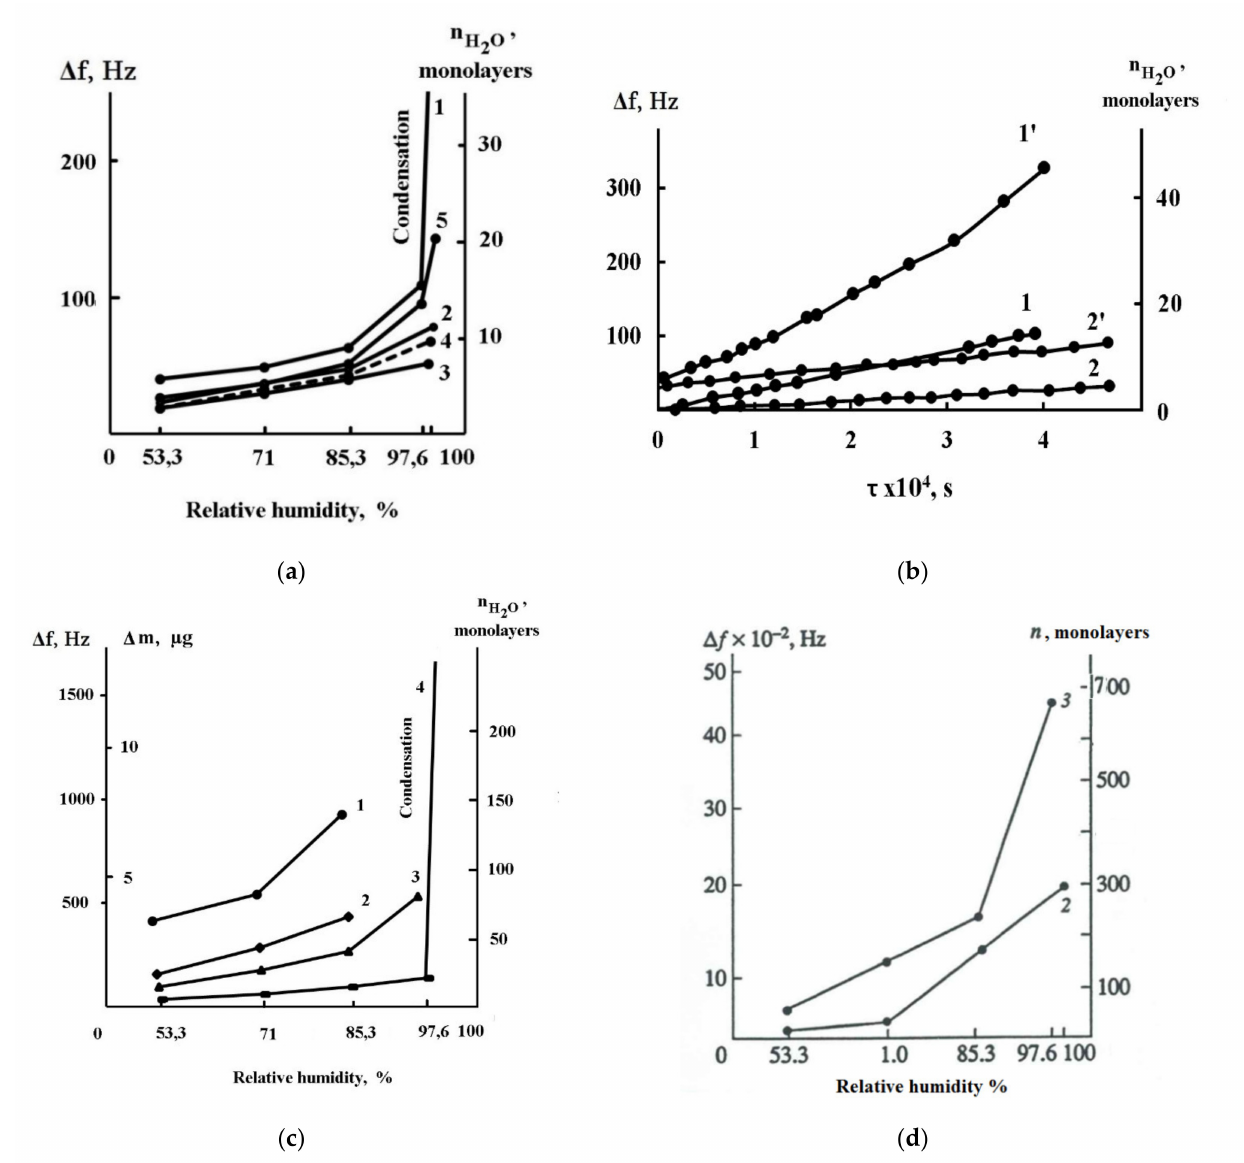
Figure 11. ( a )—QCM detection of water adsorption on the iron surface with pre-adsorbed siloxanes as function of Ar humidity ( a ). 1—bare Fe surface, 2—MTMS 5 monolayers, 3—MTMS 10 monolayers, 4—BTMS 6 monolayers, 5— BTMS 12 monolayers. ( b )—Monitoring of the frequency change and water layers gain during long time exposure of the modified surfaces in Ar flow at 100% RH. 1, 1’—BTMS and 2, 2’—MTMS. 1, 2—measurements in Ar 0% RH and 1’, 2’ measurements in Ar at 100% RH. ( c )—water adsorption vs. Ar humidity on thick siloxane films. 1—MTMS 35